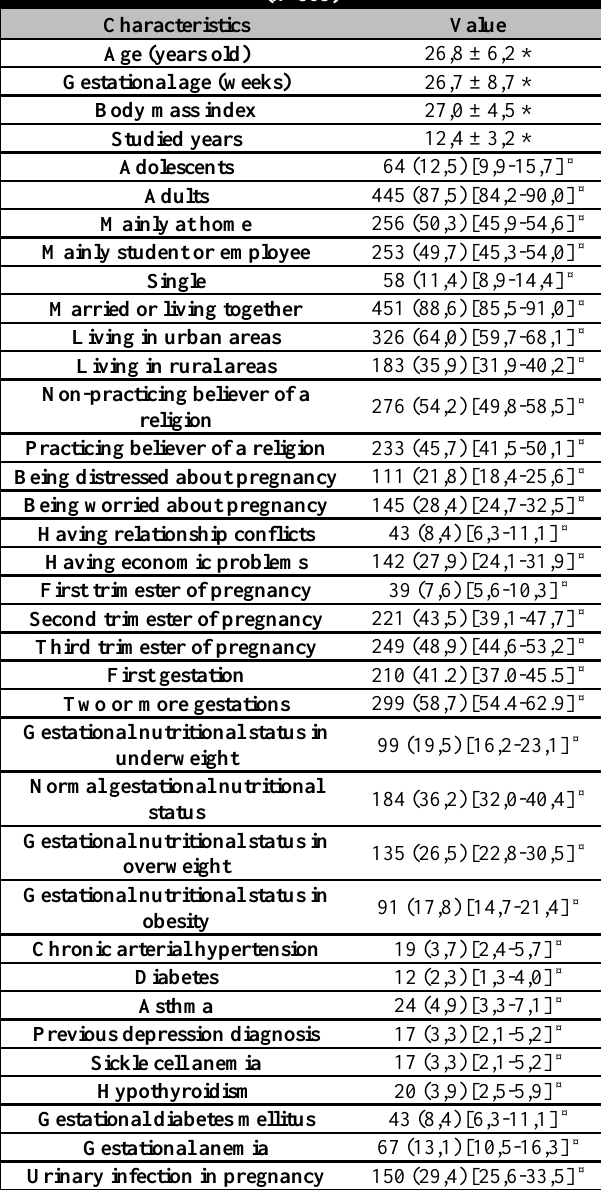
Table 1: Sociodemographics characteristics of sample (n=509)